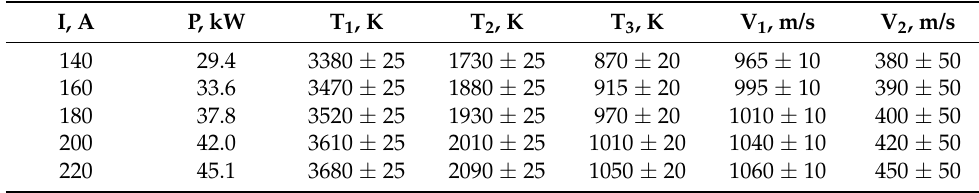
Table 1. Summary of plasma jet operational